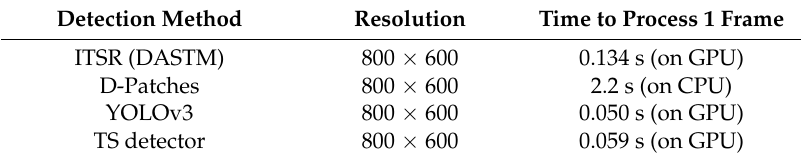
Table 3. CPU time comparison of ITSR with D-Patches, YOLOv3 and TS detector.